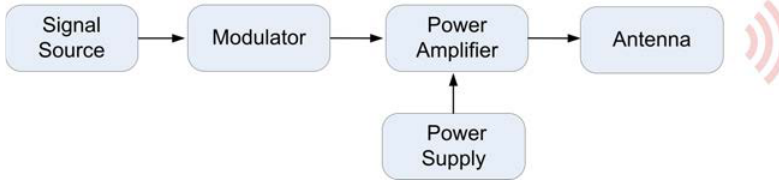
Fig. 6. Schematic diagram of modulated continuous mode.